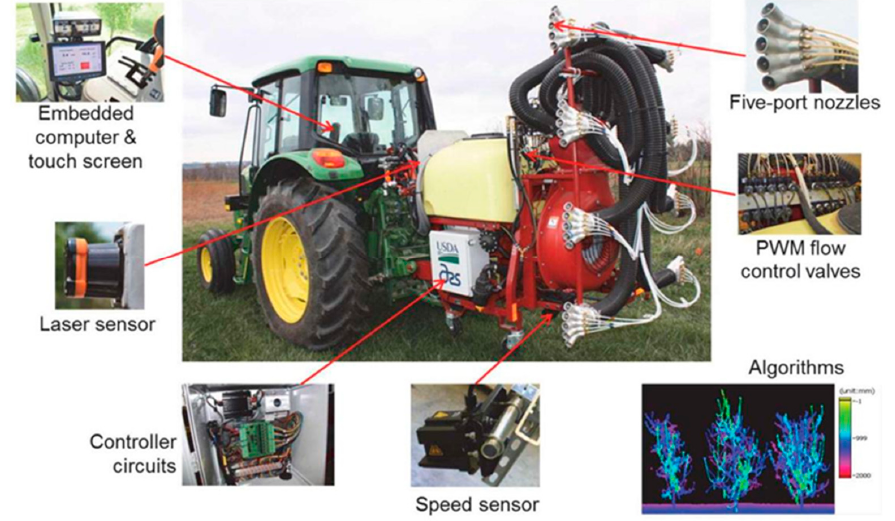
Figure 14. The laser-based variable-rate spraying system [115].